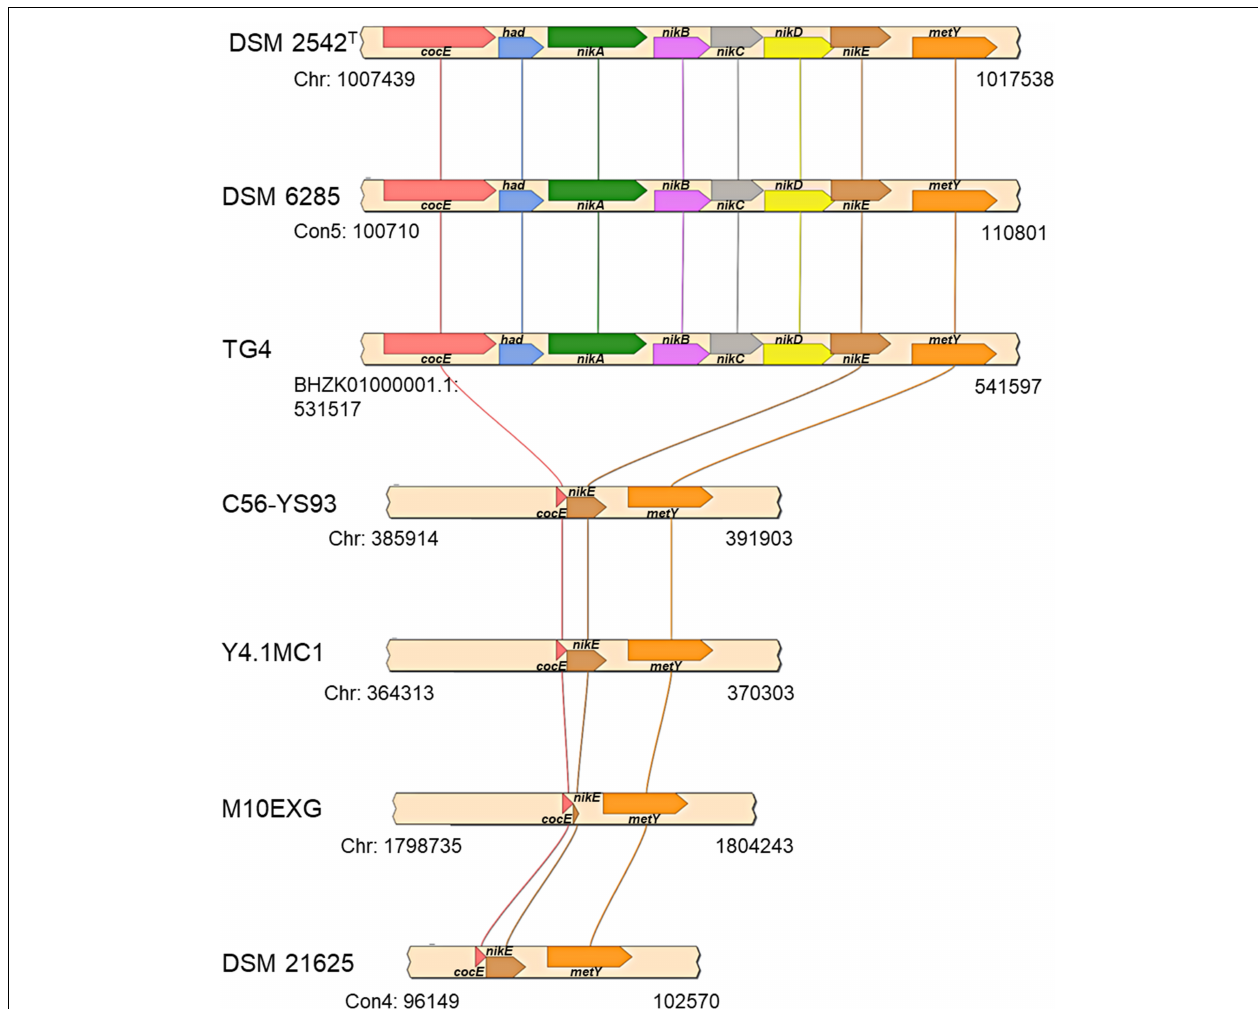
FIGURE 5 | Organization of putative nickel transport locus (HSUL 1) present on hydrogen producing P. thermoglucosidasius strains, rendered with aid of SimpleSynteny. coCE, had, nikA, nikBC, nikDE , and metY code for putative cocaine esterase, putative hydrolase of the HAD superfamily, peptide/nickel transport system substrate-binding, permease, ATP-binding proteins, and O -acetylhomoserine (thiol)-lyase,